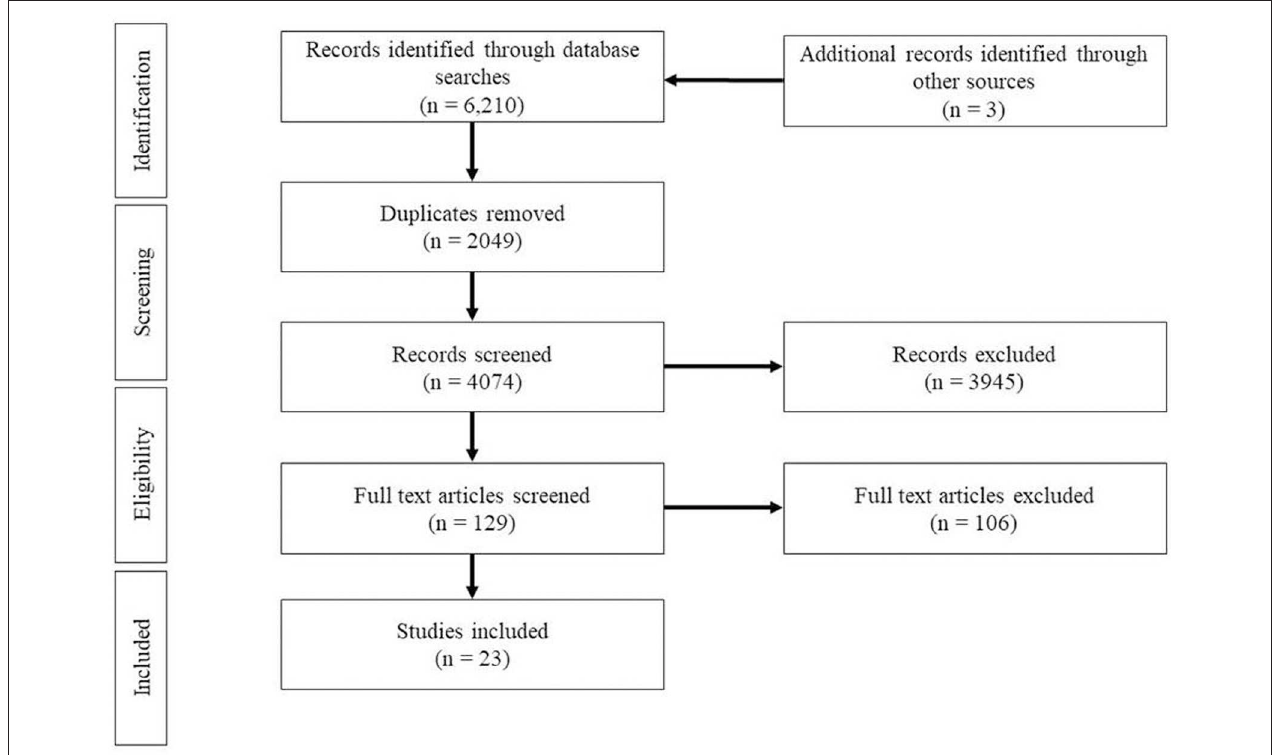
FIGURE 1 | PRISMA flow diagram of study selection